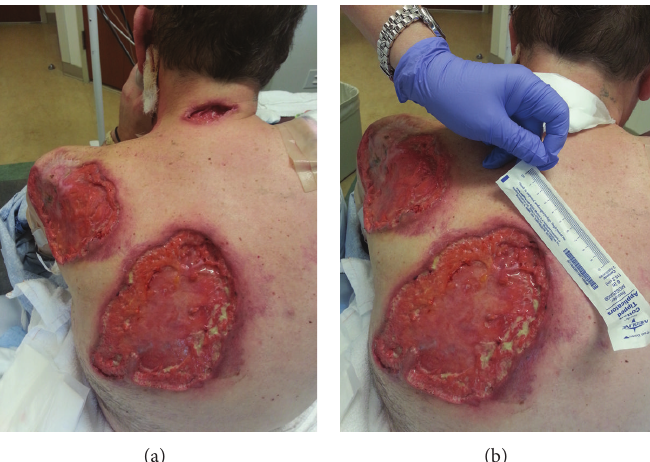
Figure 1: (a) and (b) Multiple large ulcers with irregular, violaceous, undermined borders and yellow necrotic centers, with the largest measuring 20 × 10cm.